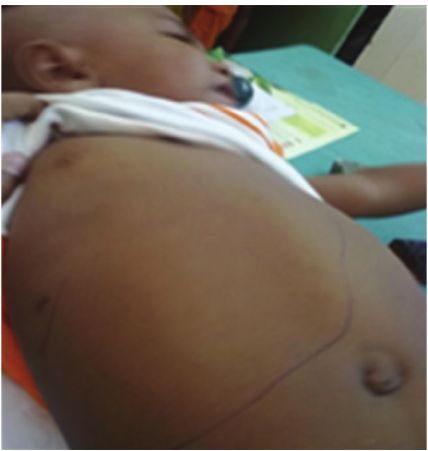
Figure 1: Showing child with huge hepatomegaly.